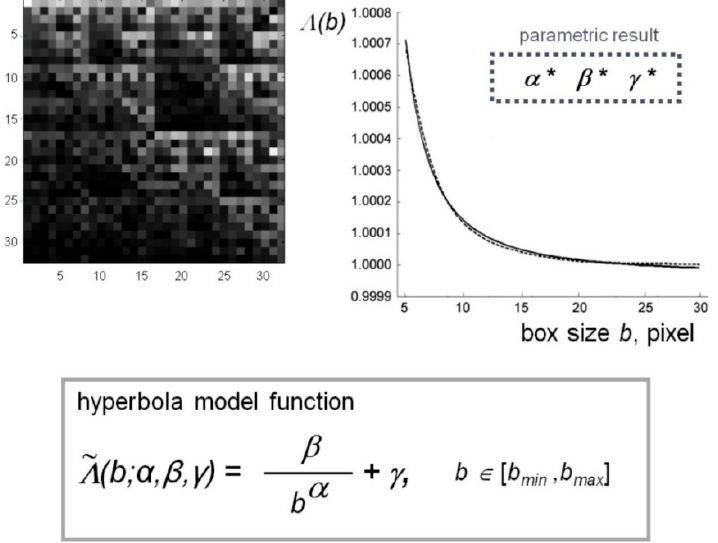
Figure 2. Rendering of fractal lacunarity method. Top left: imaging of rCRS-mtDNA generated by L = 5, so the CGR matrix is 32 × 32 square. Top right: fitting of GBA lacunarity plot (dotted line), for k , σ respectively equal to 7, 0.7, and b min , b max respectively equal to 3, 30, by hyperbola model function (solid line). Bottom: the hyperbola formula containing the three parameters α , β , γ . rCRS: revised Cambridge Reference Sequence; CGR: Chaos Game Representation; GBA: Gliding Box Algorithm.